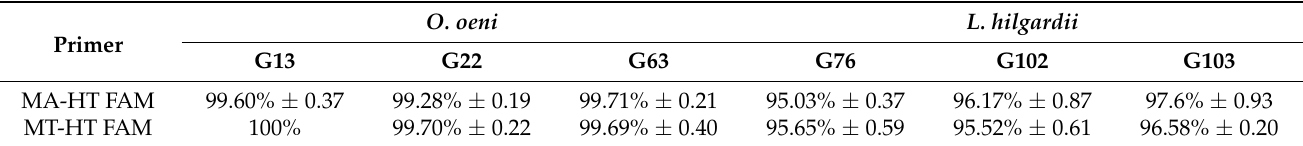
Table 4. Reproducibility ratio of